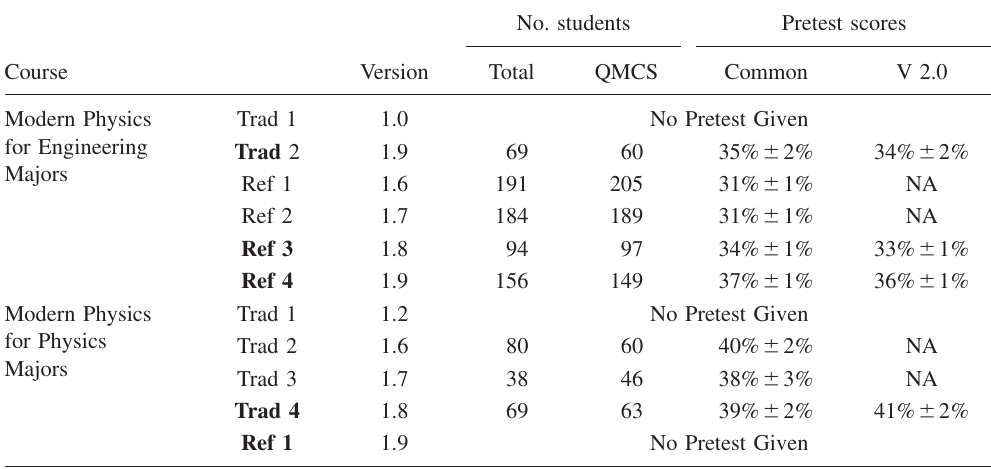
TABLE II. Average pretest scores in different modern physics courses for common questions asked all semesters and for Version 2.0 questions. V is the version number given in each course. We list the total number of students enrolled at the beginning of the semester, along with the number of students who took the QMCS pretest in each course. Uncertainties are standard errors on the mean. Courses in bold were given a version that included all questions in Version 2.0 and are thus included in the analysis of Version 2.0 in